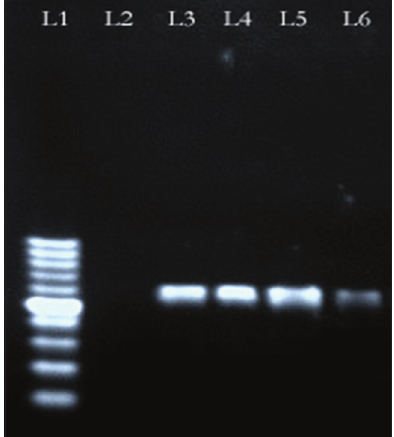
Figure-3: Polymerase chain reaction (PCR) result shows 100 bp ladder in Lane 1; Lane 2 - Negative isolates of Purulia and 602 bp amplified products in Lane 3 - Hooghly; Lane 4 - Burdwan; Lane 5 - Dakshin Dinajpur; Lane 6 - North-24 Parganas.